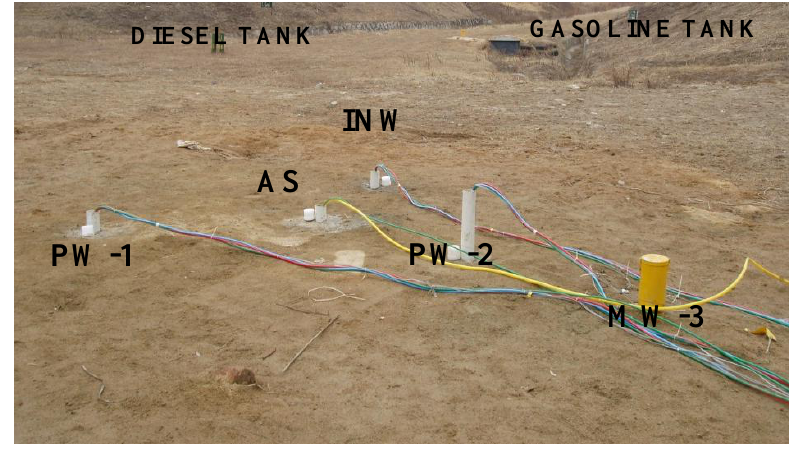
Figure 2. A photo of pilot site around MW (monitoring well) -3, including the pumping well (PW), air sparging well (AS) and surfactant injection well